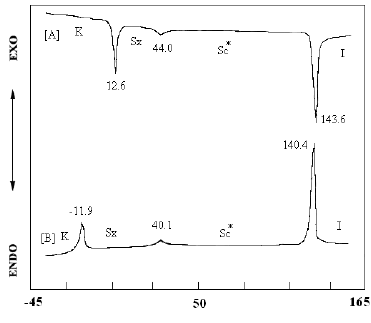
Figure 3. DSC thermograms of compound d-Si-UPBV (10 °C/min) for ( A ) second heating scanning and ( B ) cooling scanning. K = crystal; = chiral smectic C; = smectic